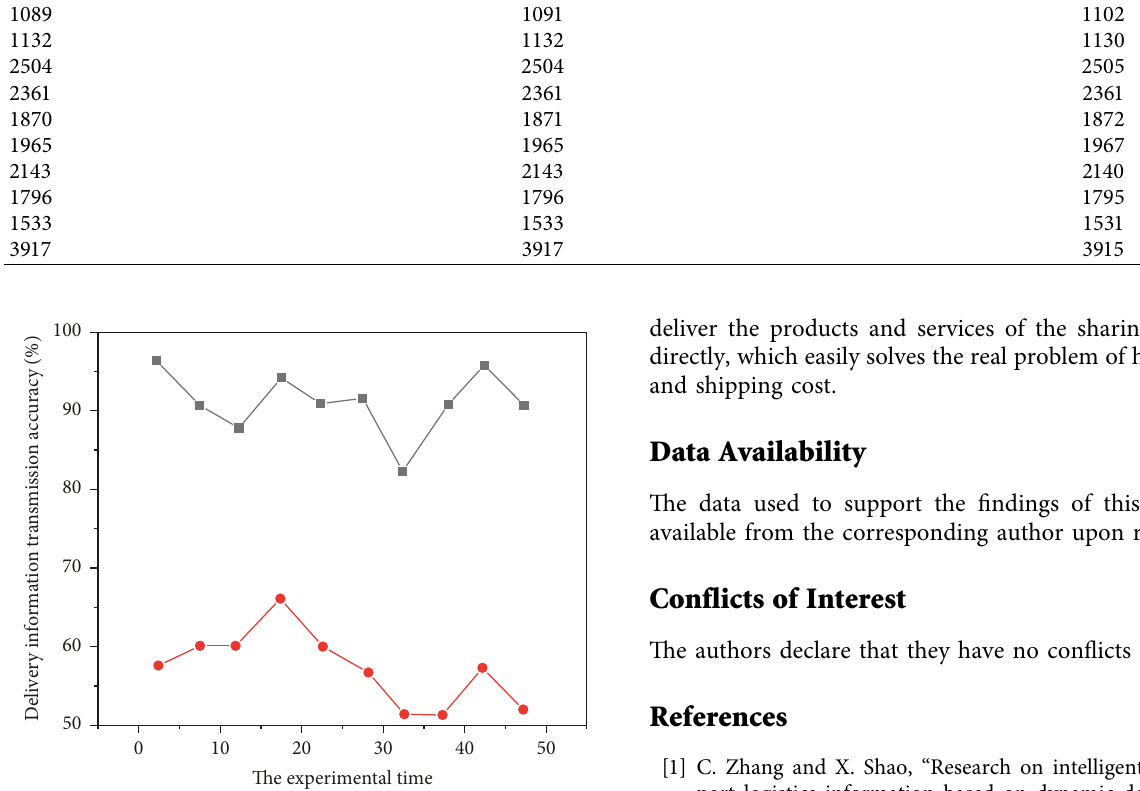
Table 2: Numerical comparison of distribution logistics (unit: piece). Actual value